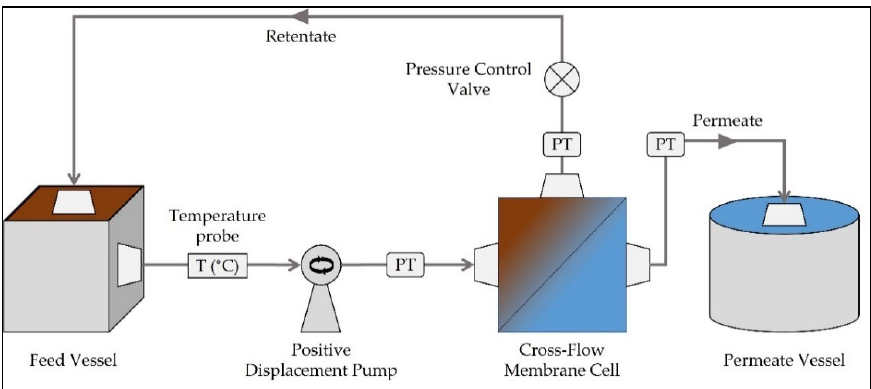
Figure 4. Schematic representation of the cross ‐ flow nanofiltration system used in this study. PT: pressure transducer.